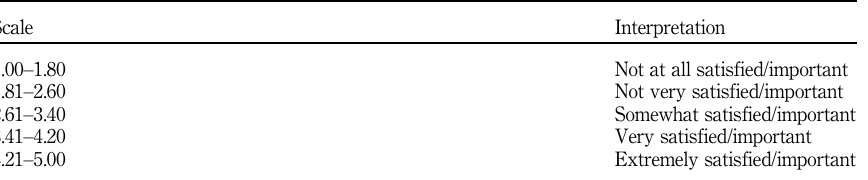
Table I. Interpretation of the